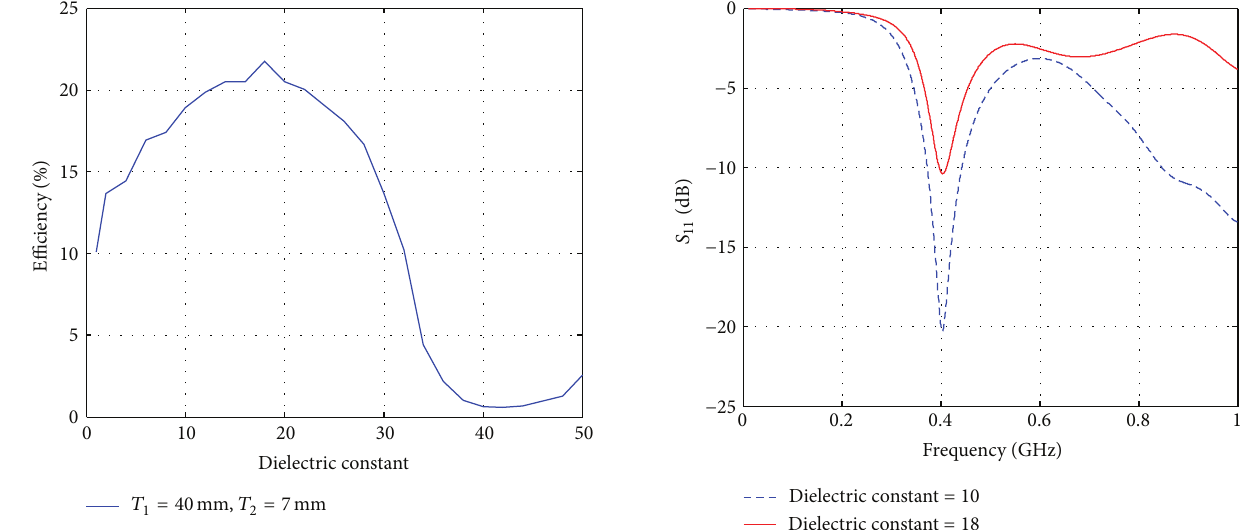
Figure 11: Reflection coefficient for two resonant points with dielectric constants 10 and 18 at 403 MHz.